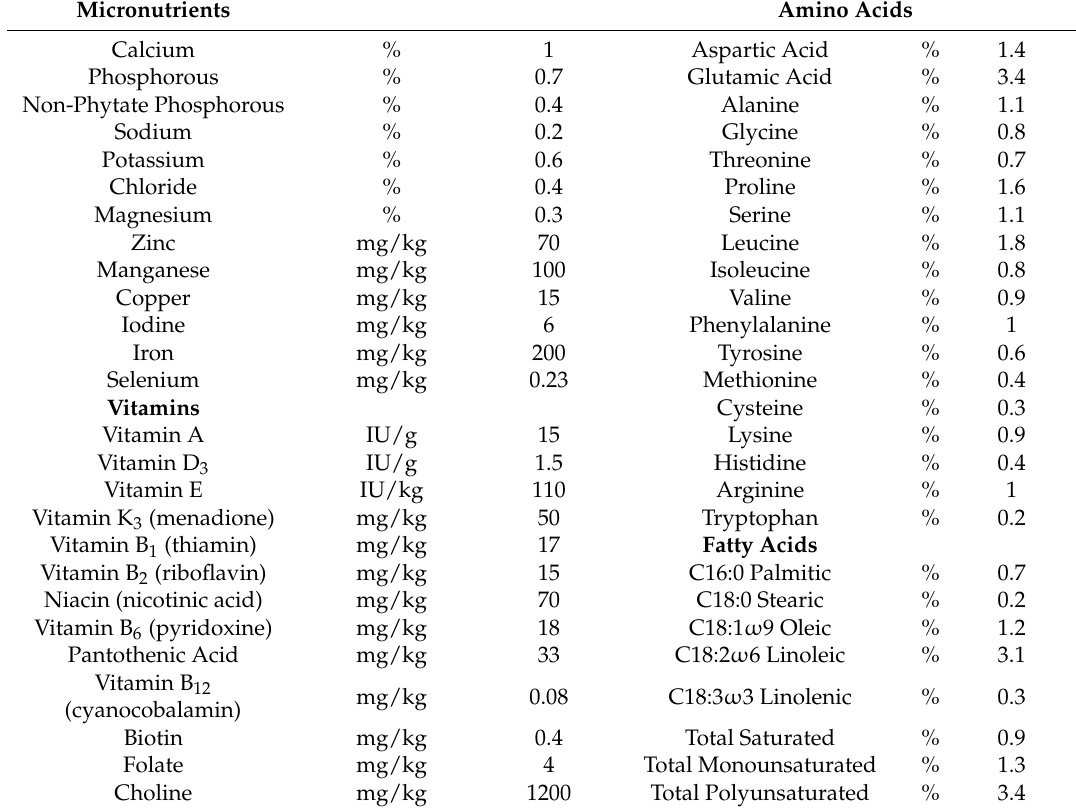
Table 3. Nutrient composition of standard